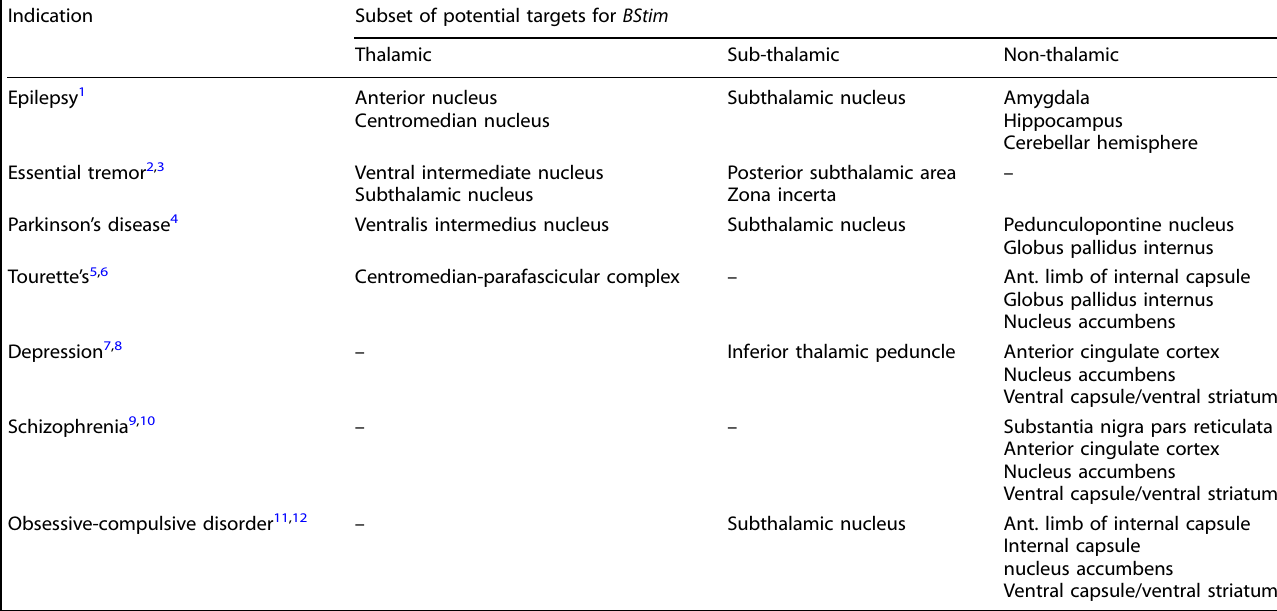
Table 1. Potential targets for BStim by indication. Most indications have BStim targets across thalamic, sub-thalamic, and non-thalamic locations. Most work to date has involved thalamic and sub-thalamic